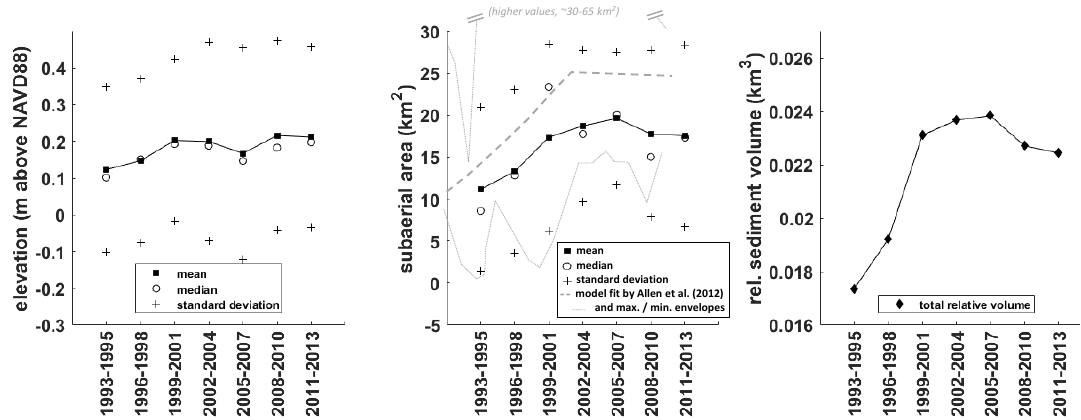
Figure 9. Progression over time of WLD average ( a ) HIME marsh top elevation, ( b ) subaerial extent, and ( c ) relative subaerial sediment volume. Time series of WLD land area extent and envelopes of maximum and minimum interannual land areas, from regression model and data by Allen et al. (2012) [90], are superimposed as gray dashed lines on ( b ).